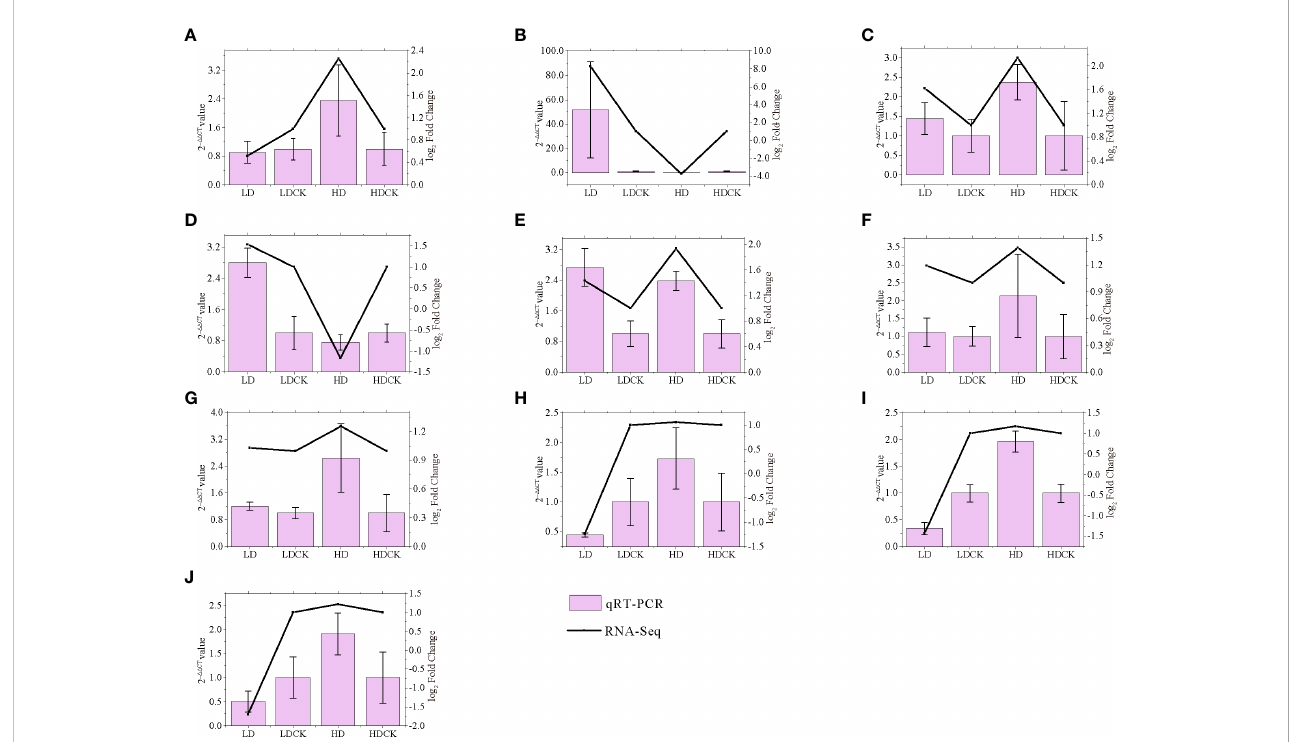
FIGURE 9 Correlation between qRT-PCR and RNA-seq based on their respective data from twelve candidate transcripts. Each point represents a fold change value of expression at LD or HD compared with that of CK (A) AGPL3; (B) P5CS2; (C) GLU3; (D) PSB28; (E) ADC2; (F) ACS1; (G) BGLU7; (H) CPA; (I) TPP9; (J)